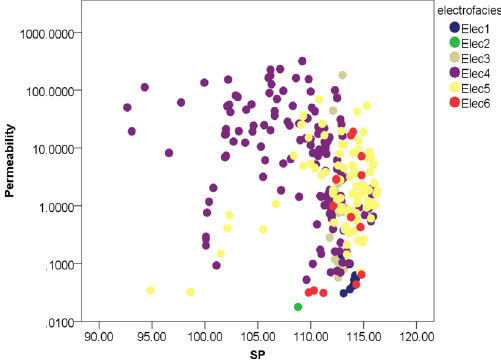
Fig. 13 SP–K crossplot in